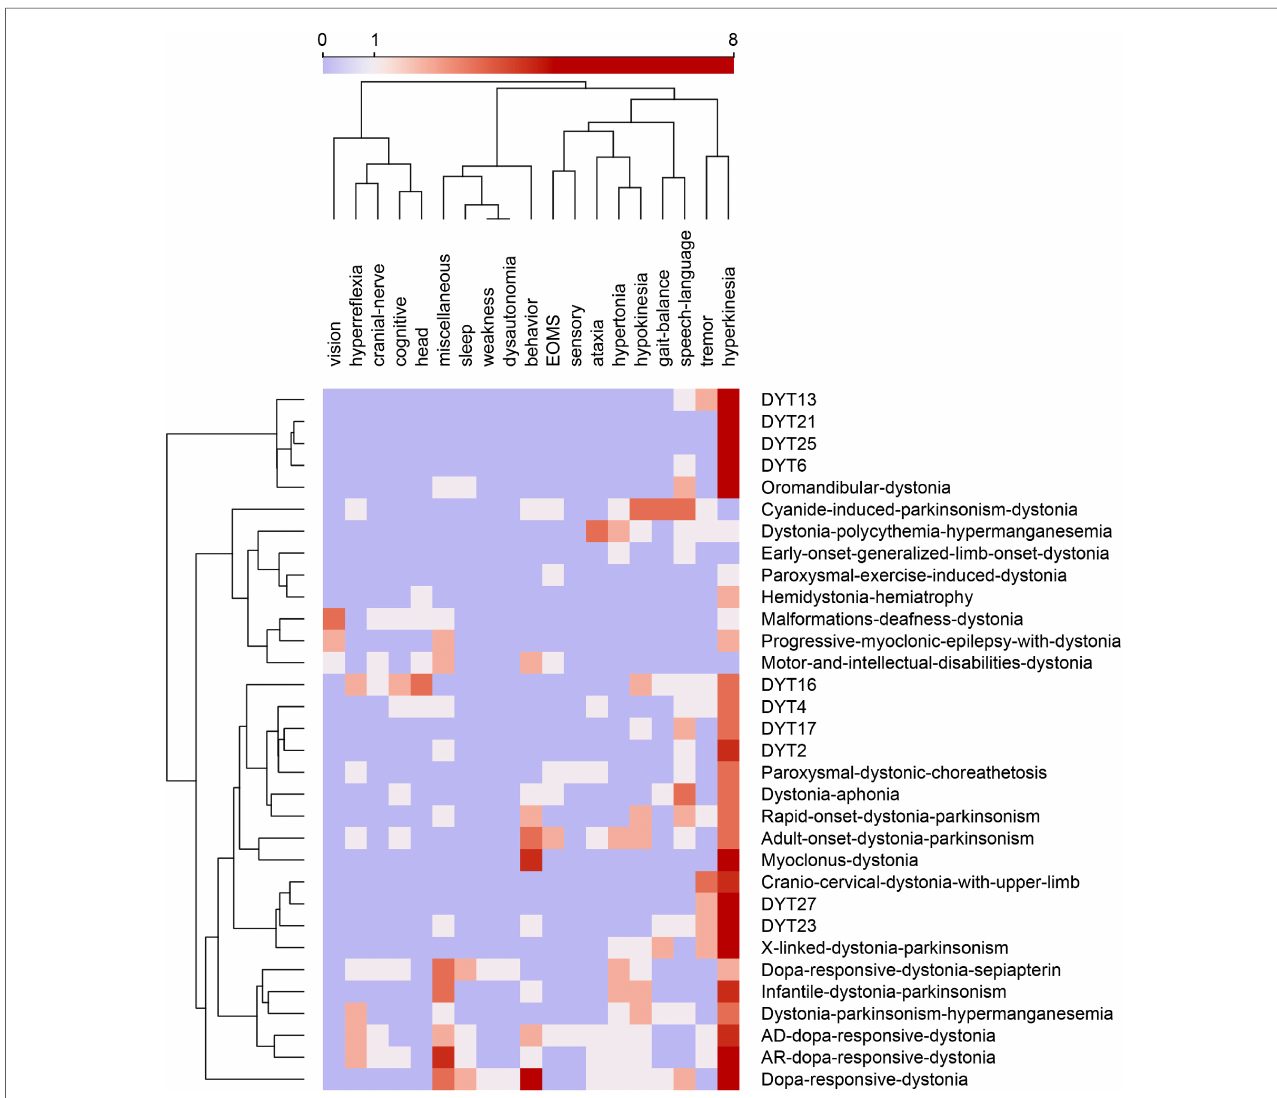
FIGURE 2 Feature map of 32 dystonias from Orphadata. Each row is a different variant of dystonia. Each column is one of 19 phenotype superclasses. Counts in columns range from 0 to 8. The color scale is centered at 1. Rows and columns are clustered by hierarchical clustering with Ward linkage. Distances between columns are by Pearson correlation coef fi cient. Distances between rows are by Euclidean distance. Hyperkinesia is the most frequent feature, followed by tremor, behavior, hypokinesia, speech_language, and miscellaneous (See word cloud in Figure 1B ). Data underlying this table is available in the Supplementary Materials